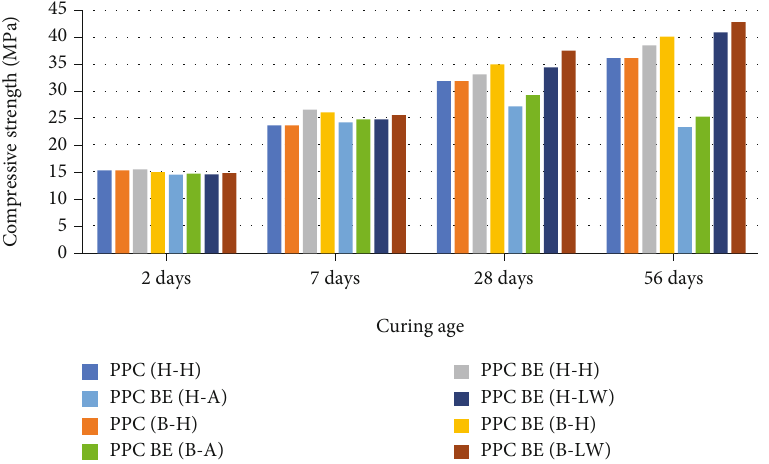
Figure 4: Compressive strength results for PPC test mortar specimens cured for 2, 7, 28, and 56